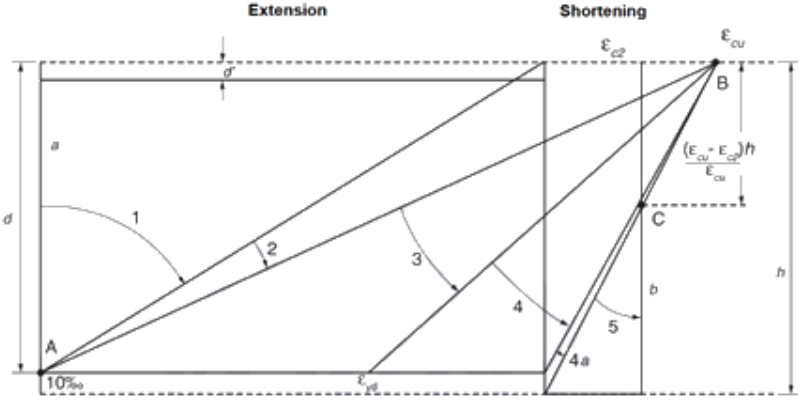
Figure 8: Failure domains for flexure [9].